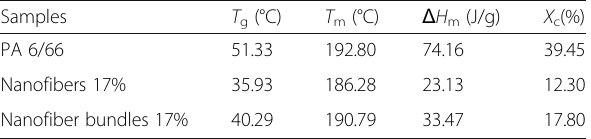
Table 1 Thermal parameters obtained by DSC results